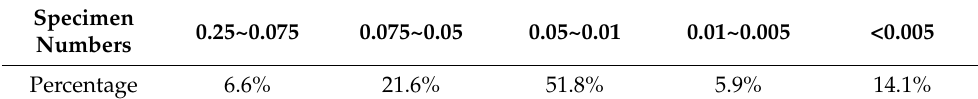
Table 2. Particle size distribution of silt.